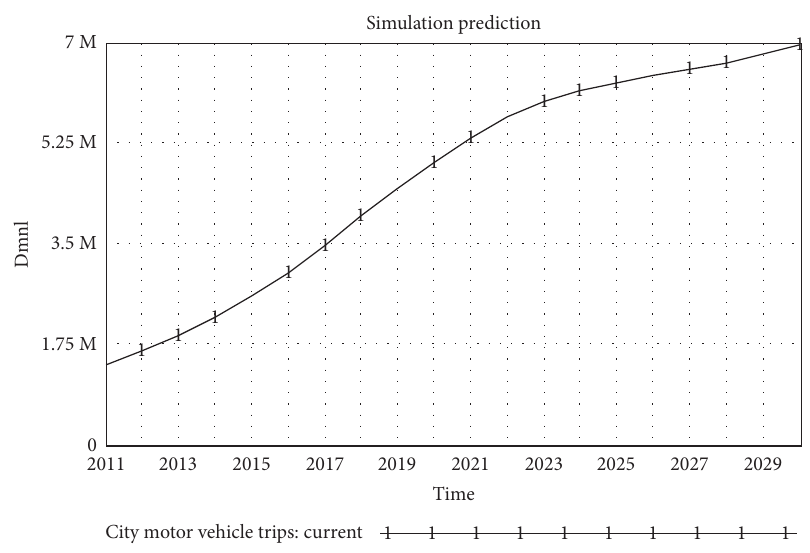
Figure 7: Changes in city motor vehicles trips over time.